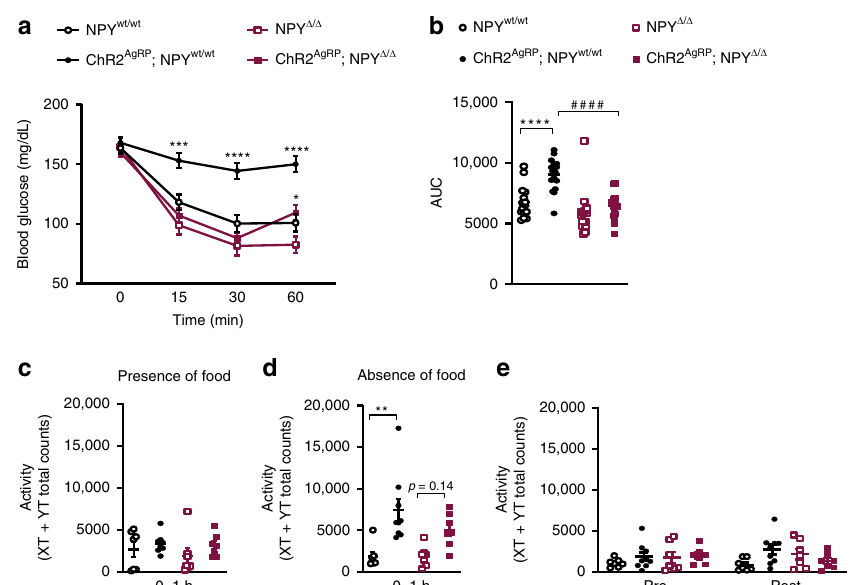
Fig. 4 NPY is necessary for the acute insulin resistance upon optogenetic activation of AgRP neurons. a, b Blood glucose levels in NPY-de fi cient and control mice during insulin tolerance tests and area under the curve (AUC); n = 15 mice for NPY wt/wt , n = 17 mice for ChR2 AgRP ; NPY wt/wt and ChR2 AgRP ; NPY Δ / Δ and n = 18 mice for NPY Δ / Δ ). c , d Locomotor activity during optogenetic AgRP neuron stimulation in the presence and in the absence of food is largely independent of NPY expression ( n = 7 mice for NPY wt/wt , NPY Δ / Δ and ChR2 AgRP ; NPY Δ / Δ and n = 9mice for ChR2 AgRP ; NPY wt/wt ). e Locomotor activity one hour prior light illumination of the ARC (pre) and one hour after laser was turned off (post) is similar in all genotypes ( n = 7 mice for NPY wt/wt , NPY Δ / Δ and ChR2 AgRP ; NPY Δ / Δ , and n = 9 mice for ChR2 AgRP ; NPY wt/wt ). Data are shown as mean ± s.e.m. Statistical analysis is represented by * p ≤ 0.05, ** p ≤ 0.01,*** p ≤ 0.001, **** p ≤ 0.0001, and #### p ≤ 0.0001 as determined by two-way ANOVA followed by Tukey post hoc test, except in b and d in which a one-way ANOVA followed by Tukey post hoc test was used. # represents comparisons between NPY-expressing and NPY-de fi cient animals. Source data are provided as a Source Data fi